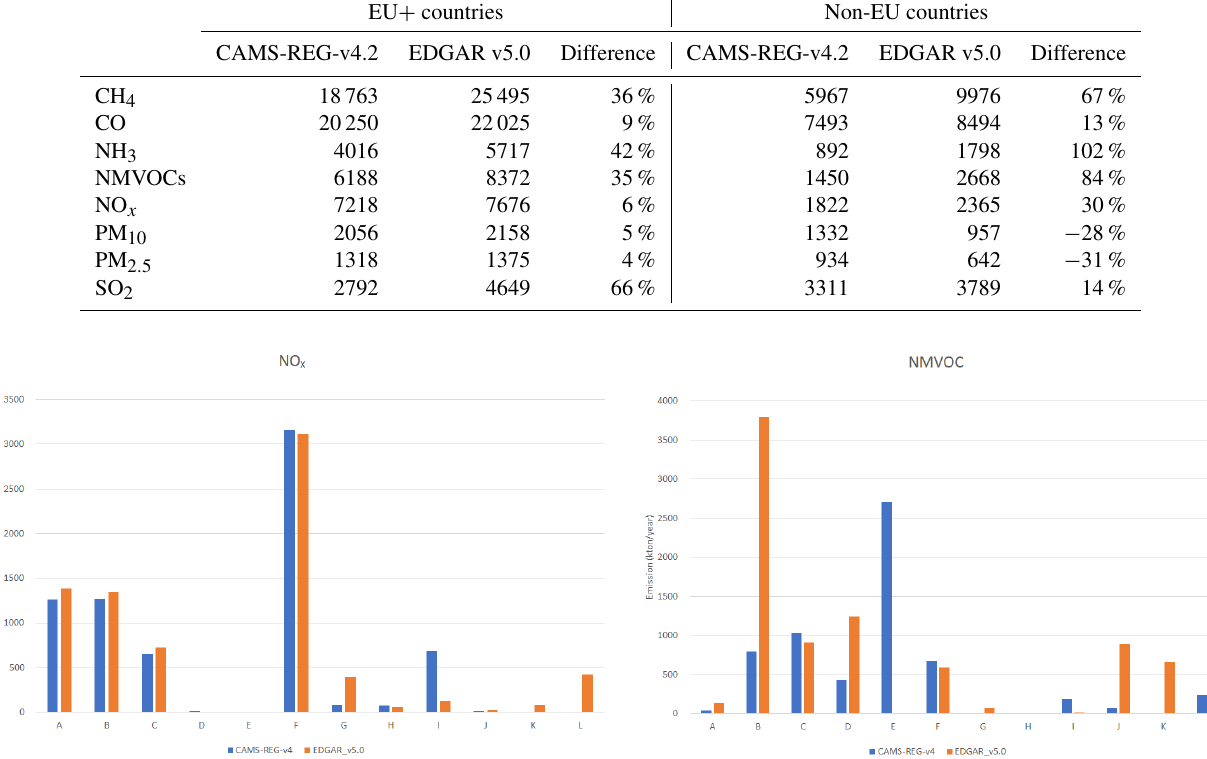
Table 4. Comparison between total annual emissions for 2015 from CAMS-REG-v4.2 and EDGAR-v5.0 for EU + countries (left) and non-EU countries (right), excluding the Russian Federation (emissions in kilotonnes).